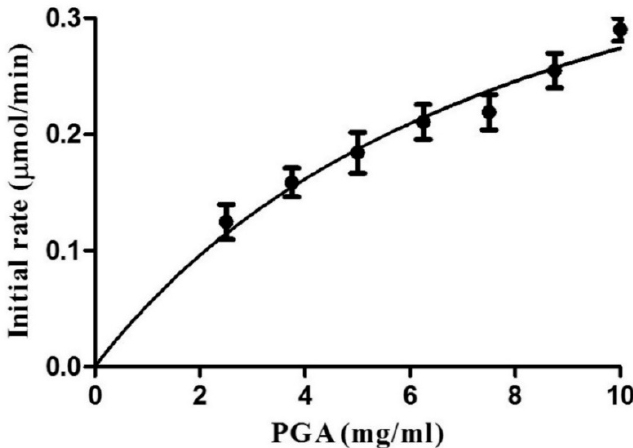
Figure 5. E ff ects of PGA (polygalacturonic acid) concentration on AnEPG activity. Figure 5. Effects of PGA (polygalacturonic acid) concentration on AnEPG activity.